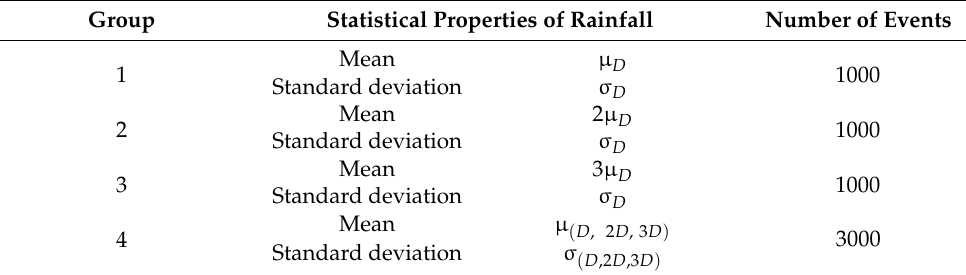
Table 2. Statistical properties and number of the produced rainfall events. Group Statistical Properties of